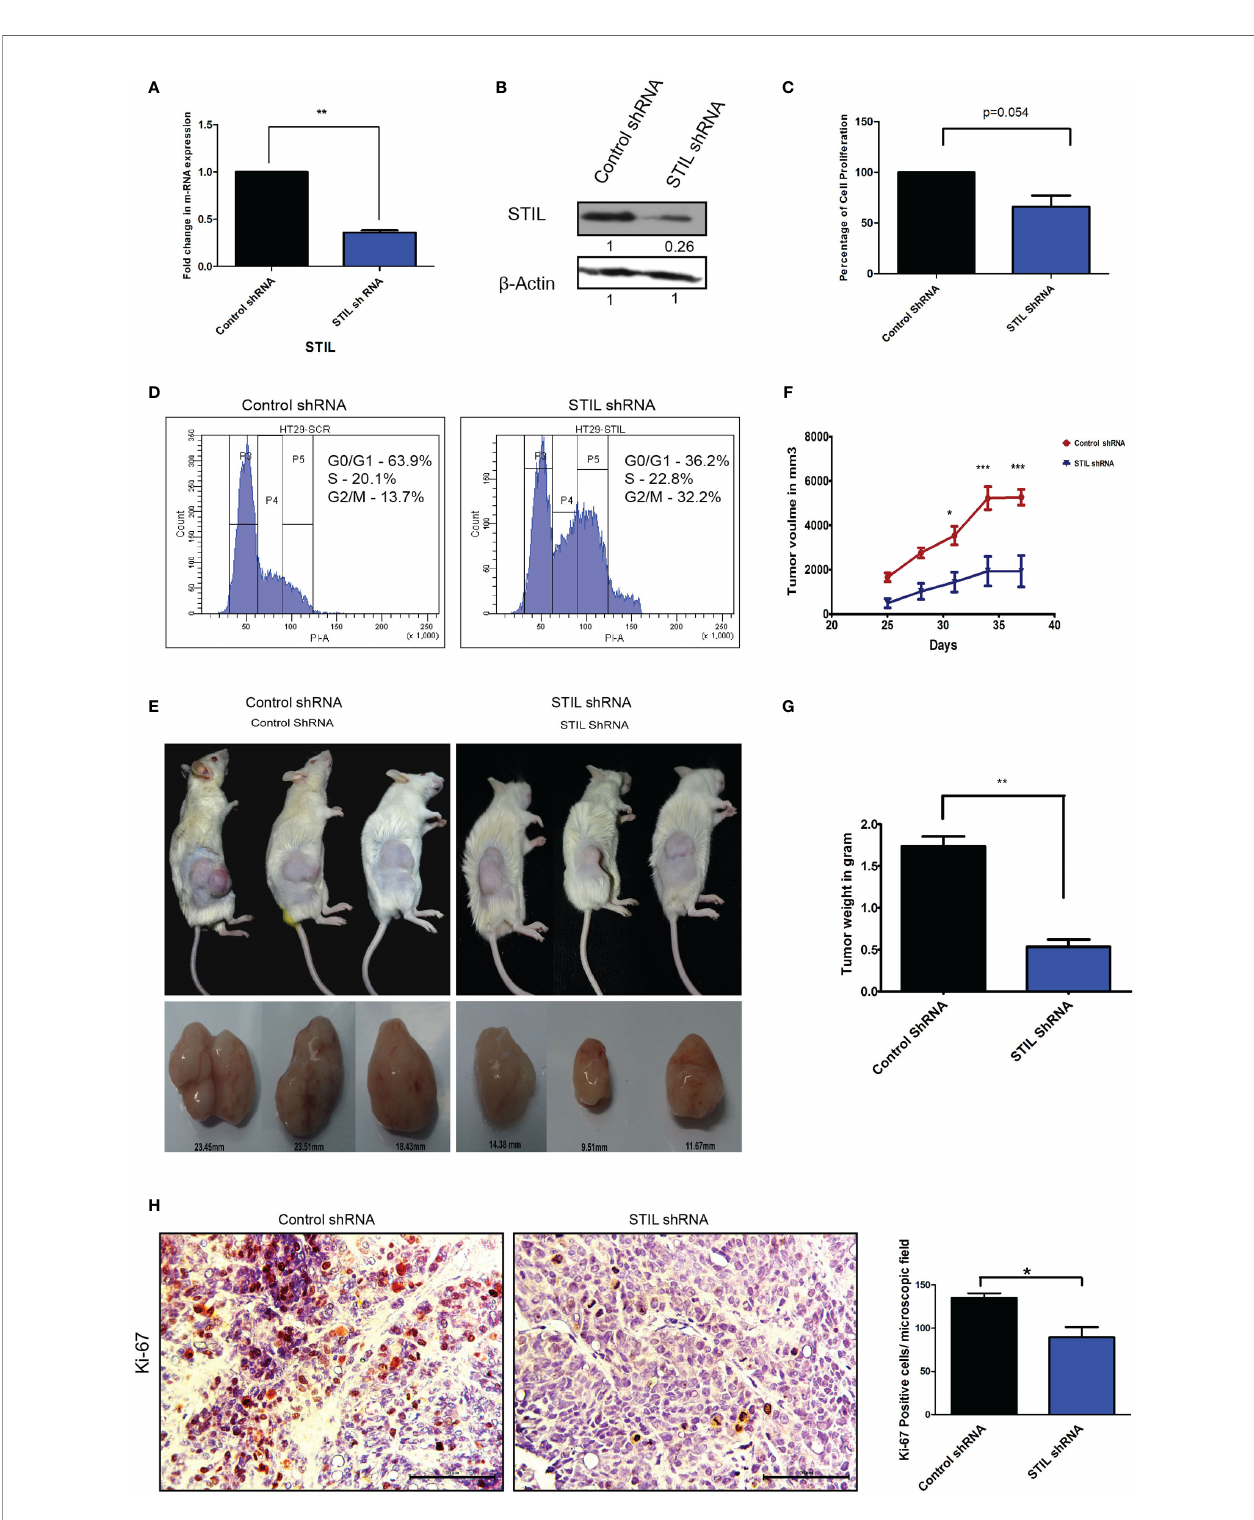
FIGURE 3 | Role of STIL in CRC tumorigenesis. (A) Bar graph showing fold change in STIL mRNA expression upon STIL silencing. (B) Immunoblot validating STIL silencing at protein level. (C) Bar graph showing cell proliferation of HT-29 cells upon STIL silencing. (D) Histogram showing effect of STIL silencing on cell cycle. (E, F) Representative images of tumor xenograft and graph showing growth of tumor upon time (n = 3). (G) Bar graph showing mean dry weight of tumor in both groups (n = 3). (H) IHC showing nuclear expression and quanti fi cation of Ki-67 protein in xenograft derived tumor tissues. Unpaired t-test results showing p value ≤ 0.05, ≤ 0.01, ≤ 0.001 are represented by *, **, ***, respectively, Scale bar is 20